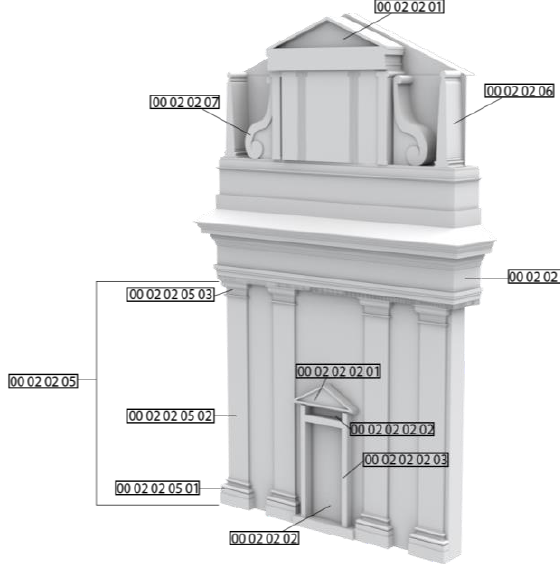
Figure 12. Labelling of the entities related to the 3D model of the